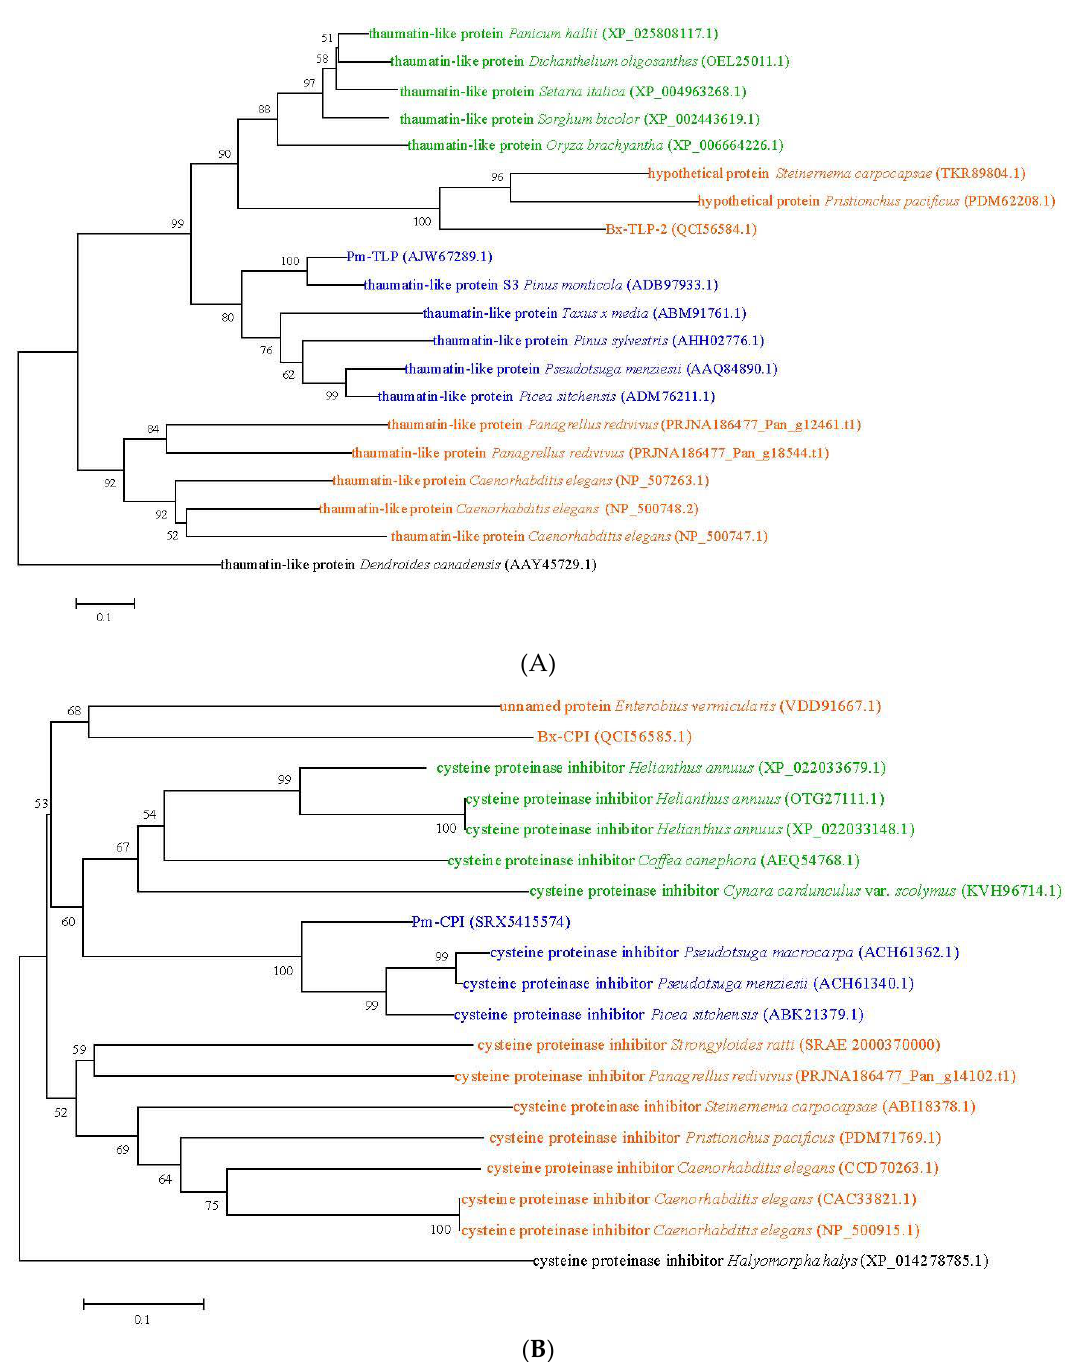
Figure 5. The phylogenetic tree of ( A ) Bx-TLP-2 and ( B ) Bx-CPI. The phylogenetic tree was reconstructed by MEGA-X software with the neighbor-joining (N-J) method, and the bootstrap value was set for 500 replicates. Species have identical colors: green indicates herbs, blue indicates woody plants, orange indicates nematodes and black indicates insects.